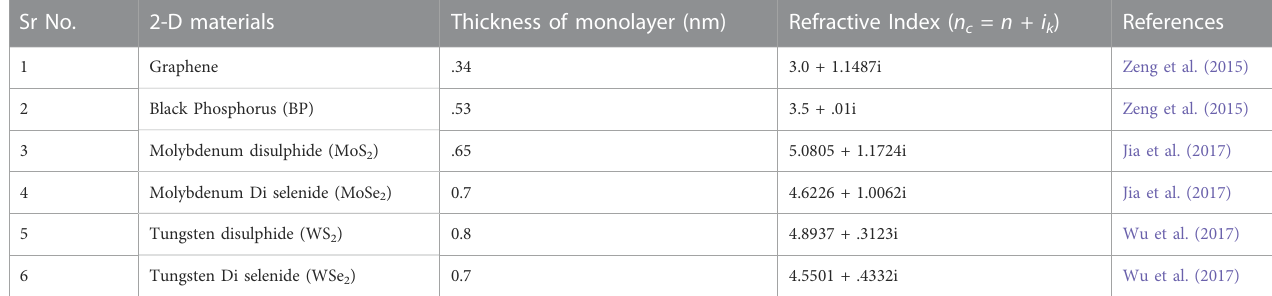
TABLE 2 Refractive Index values for the different 2-D Materials. Sr